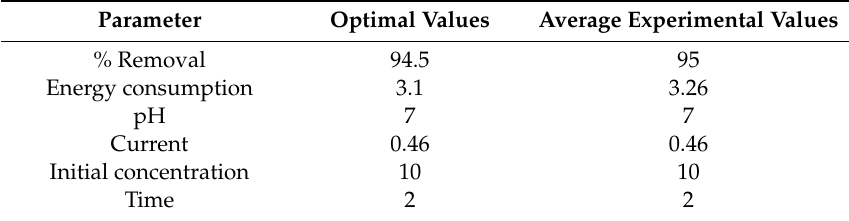
Table 4. Optimal values of chosen